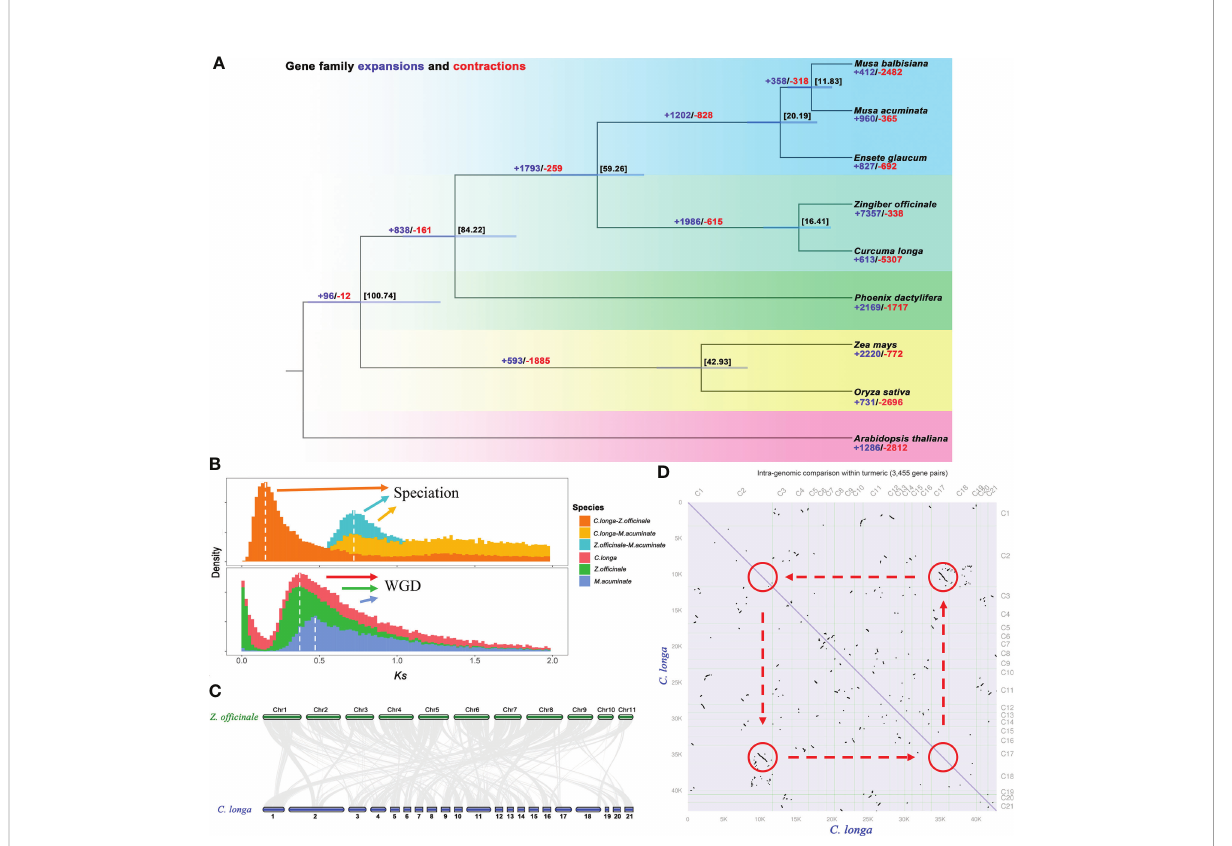
FIGURE 4 Genome comparison and evolution analysis. (A) Phylogenetic tree of C. longa and eight other species based on single-copy protein sequences, and divergence times (Mya) are indicated by the numbers beside the branch nodes. The numbers of contracted gene families are in blue, and those of expanded gene families are in red. (B) Distribution of the synonymous substitution (Ks) rates for C. longa , Z. of fi cinale , and M. acuminate genome, peaks in the intraspecies Ks distribution indicate whole-genome polyploidization events, and peaks in the interspecies Ks distribution indicate speciation events. (C) Synteny conservation between C. longa and Z. of fi cinale genomes. (D) Dot plots of paralogs in the C. longa